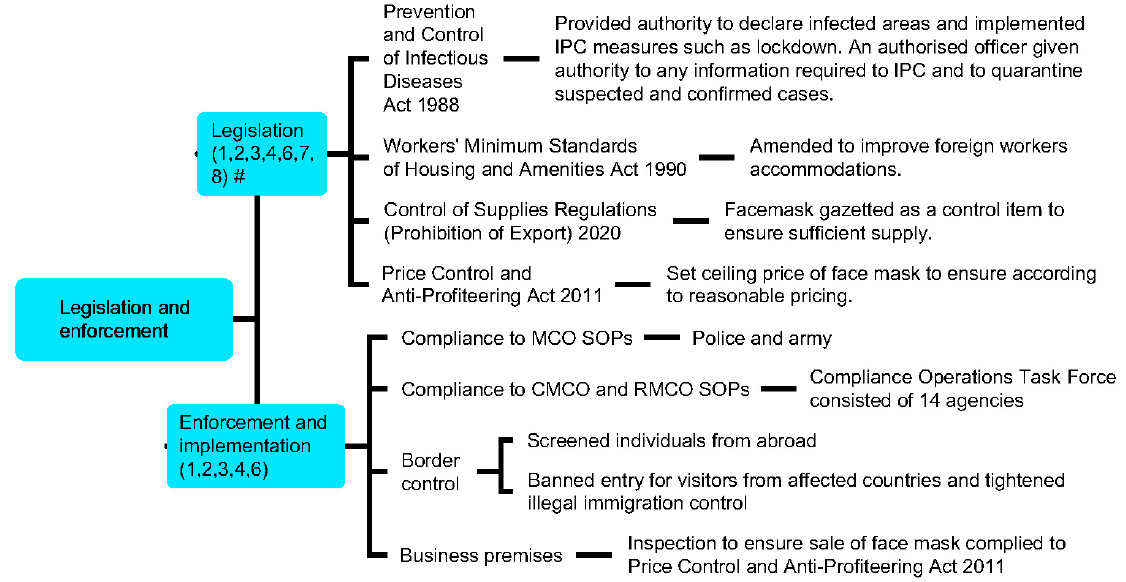
Figure 5. Equity of access to services and support provided by the Malaysian government during the COVID-19 pandemic. # Numbers in parentheses denote WHO Pillars.